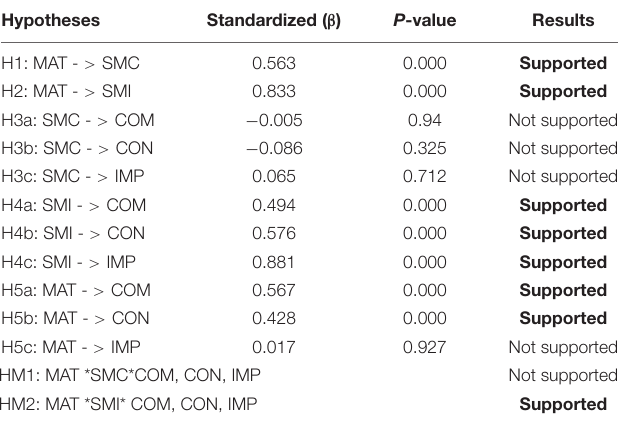
TABLE 5 | Results of structural equation model